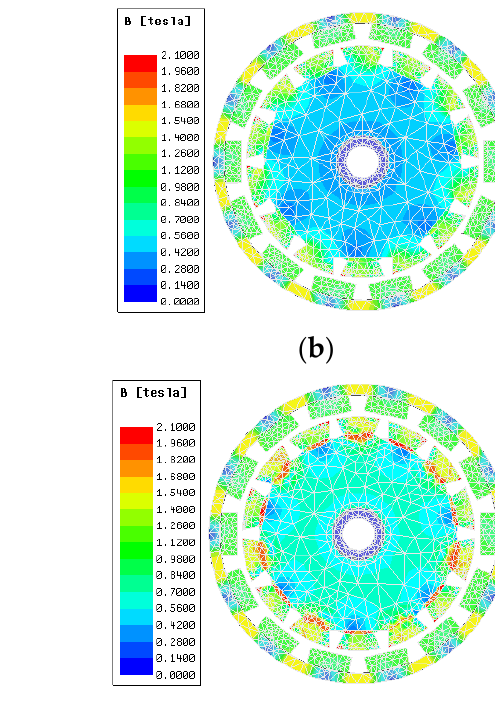
Figure 25. The relationship between the MMF and the electromagnetic torque.